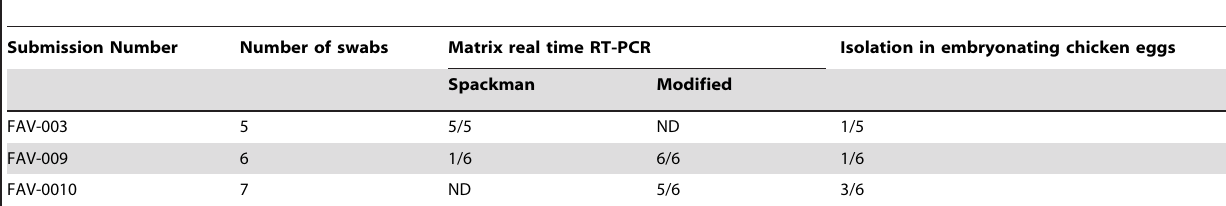
Table 1. Influenza A matrix gene real time RT-PCR and virus isolation results for the swab specimens received from the three turkey